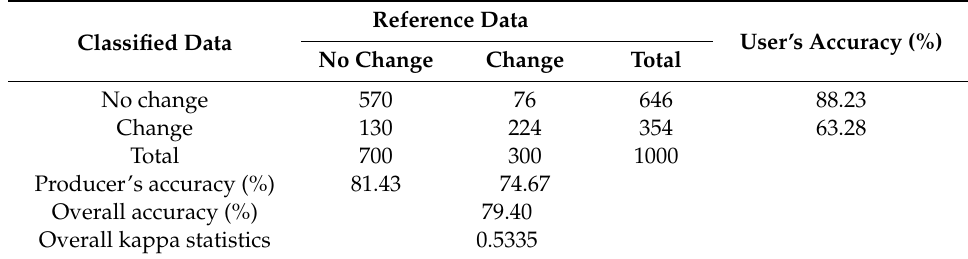
Table 9. Binary change detection error matrix for the MCVA_OB method.